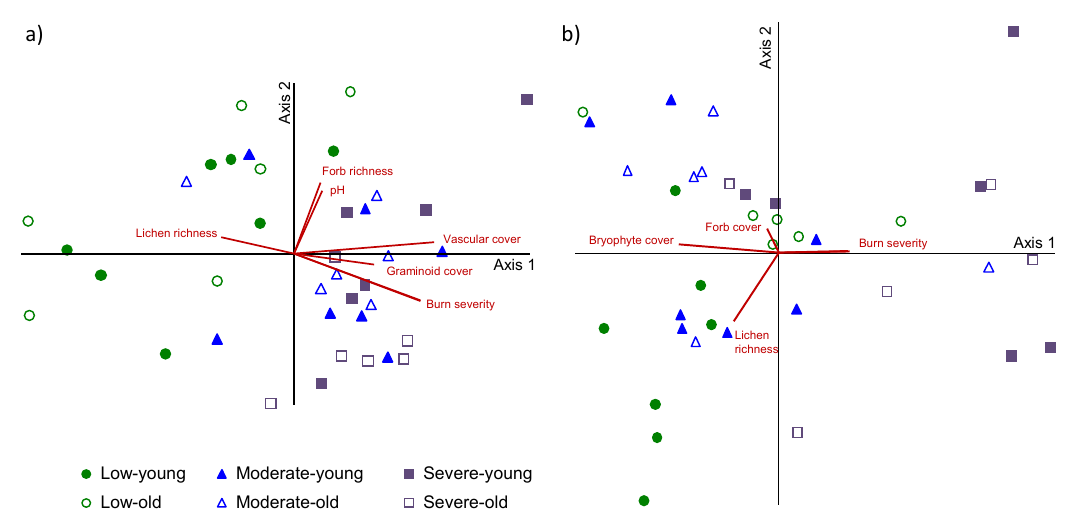
Figure 4. Non-metric multidimensional scaling ordination including only ( a ) vascular plants or ( b ) non-vascular plants. The environmental overlays present the most significant relationships for each species group, burn severity and soil chemistry with r > 0.5.